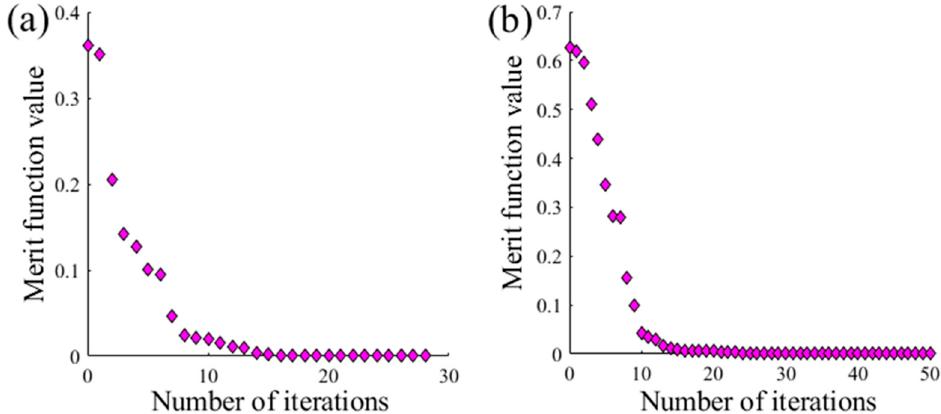
Figure 7. Progression of the optimization for ( a ) 1 × 9 and ( b ) 1 × 15 spot array in the simulation.